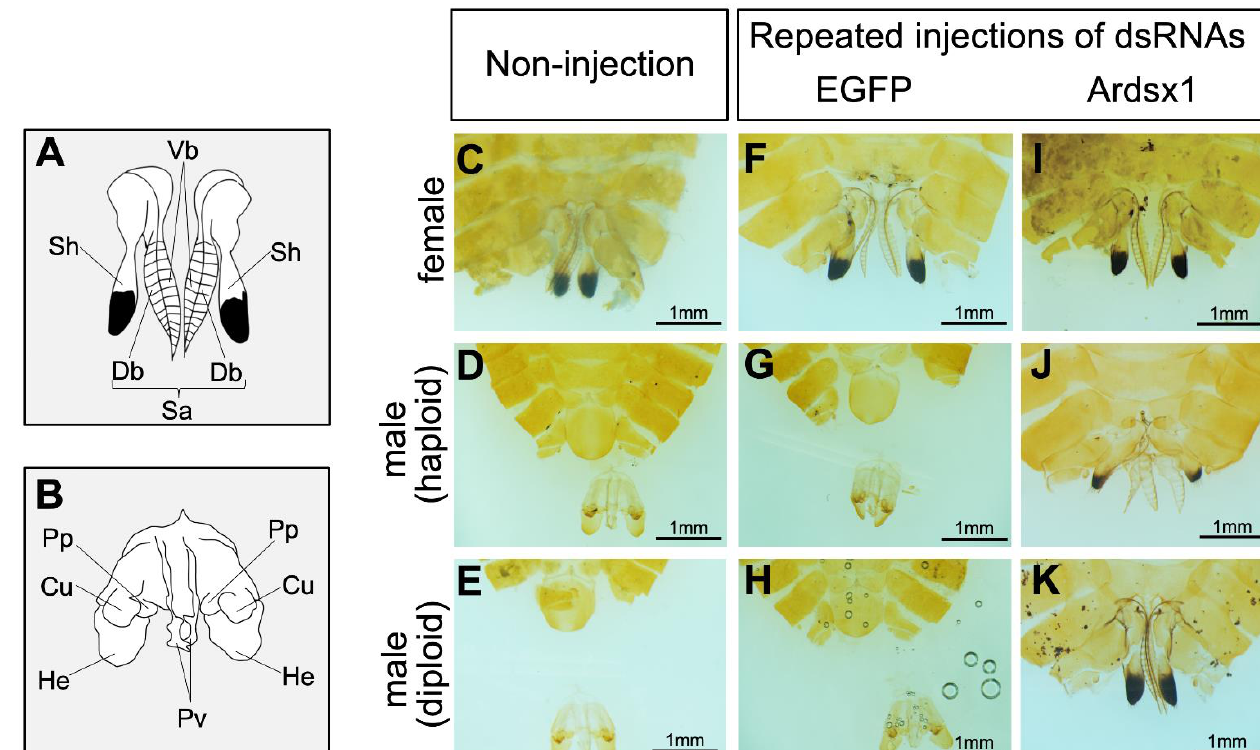
Figure 2. Effects of RNAi-mediated knockdown of Ardsx on sexual development of external genital organs. ( A , B ) Schematic diagrams of female ( A ) and male ( B ) external genital organs. Db, dorsal pair of blades; Sa, saw; Sh, sheath; Vb, ventral pair of blades; Cu, cuspis; He, herpe; Pp, parapenis; Pv, penis valve. ( C – K ) Ventral view of the external genitalia at the adult stage. Female ( C ), haploid male ( D ), and diploid male ( E ) without injection of dsRNA. Negative control female ( F ), haploid male ( G ), and diploid male ( H ) obtained via repeated injections of EGFP dsRNA. Ardsx -knockdown female ( I ), haploid male ( J ), and diploid male ( K ) obtained via repeated injections of Ardsx1 dsRNA. Table 1. Number of injected animals, adults subjected to the analysis, and adults that exhibited sex-reversal phenotype. No. of Injected Animals No. of Investi- Sexual Phenotypes * 2 dsRNA Sexuality gated Adults 3rd Instar Last Instar Normal Sex-Reversal EGFP